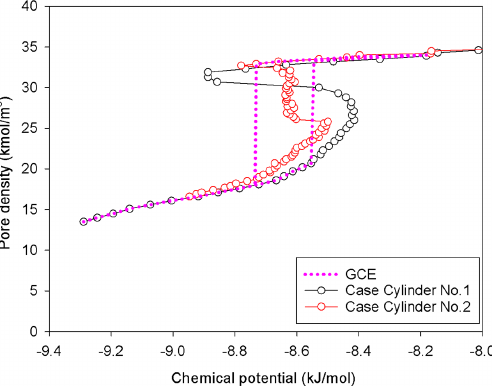
Figure 7. GCE and MCE nitrogen adsorption isotherms in the infinite cylindrical pore of 5 nm in diameter at 77 K.